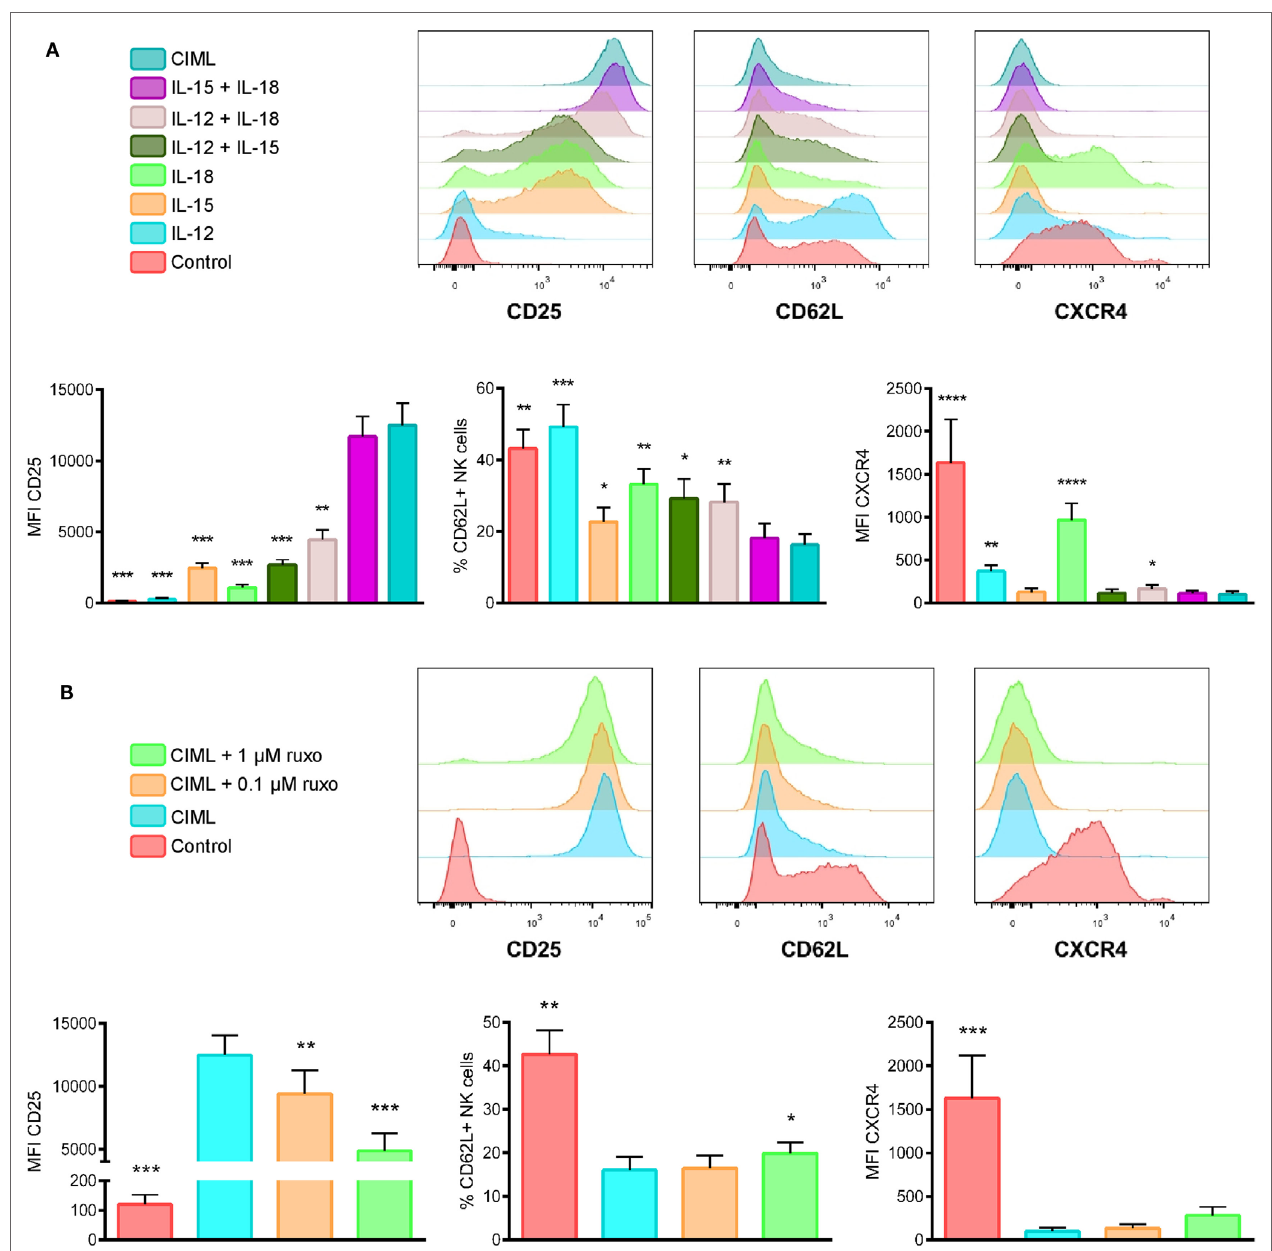
FigUre 4 | Phenotype of cytokine preactivated natural killer (NK) cells after the preactivation phase. (a) Representative experiment (top) and bar graphs (bottom) showing the expression of CD25, CD62L, and CXCR4 on control non-preactivated and cytokine preactivated NK cells ( n = 8). (B) A representative experiment (top) and bar graphs (bottom) showing the expression of CD25, CD62L and CXCR4 on control non-preactivated and cytokine-induced memory-like (CIML) NK cells, and CIML NK cells preactivated in the presence of 0.1 and 1 µM ruxolitinib ( n = 8). The bar graphs show the mean with SEM. Differences between CIML NK cells and the rest of conditions were established with RM one-way ANOVA with the Greenhouse-Geisser correction (for normally distributed data) or Friedman test (for non-normal distributed data). * p < 0.05, ** p < 0.01, *** p < 0.001, **** p <